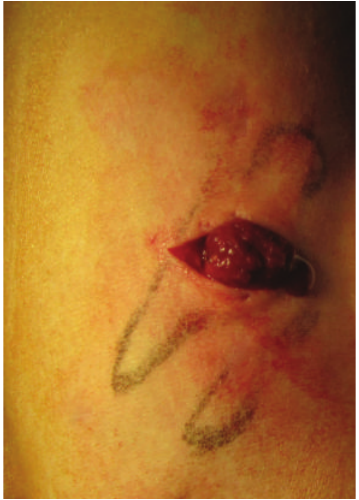
Figure 1: Perioperative finding.